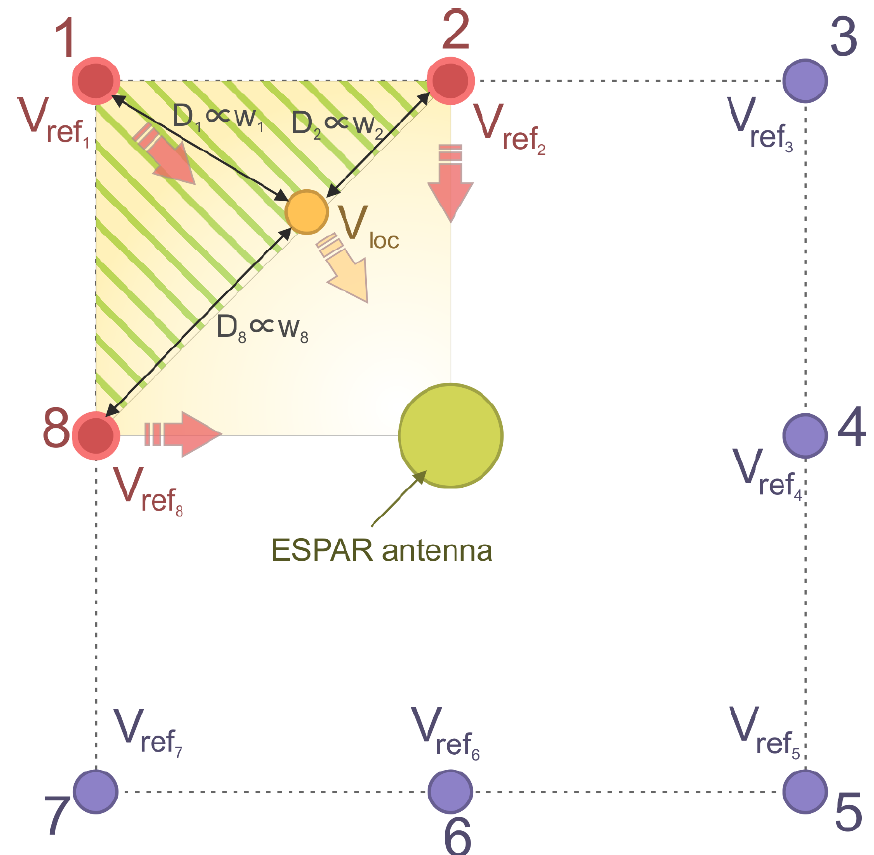
Figure 4. Proposed calibration-free algorithm overview. The position of localized node V loc (marked as a yellow dot) is calculated using 3 reference nodes ( K = 3, marked in red), for which the associated < D < D Euclidean distances D j = k j = k 1 j = k 8 calculated in the first phase of the estimation are the 2 smallest (see text for explanations).